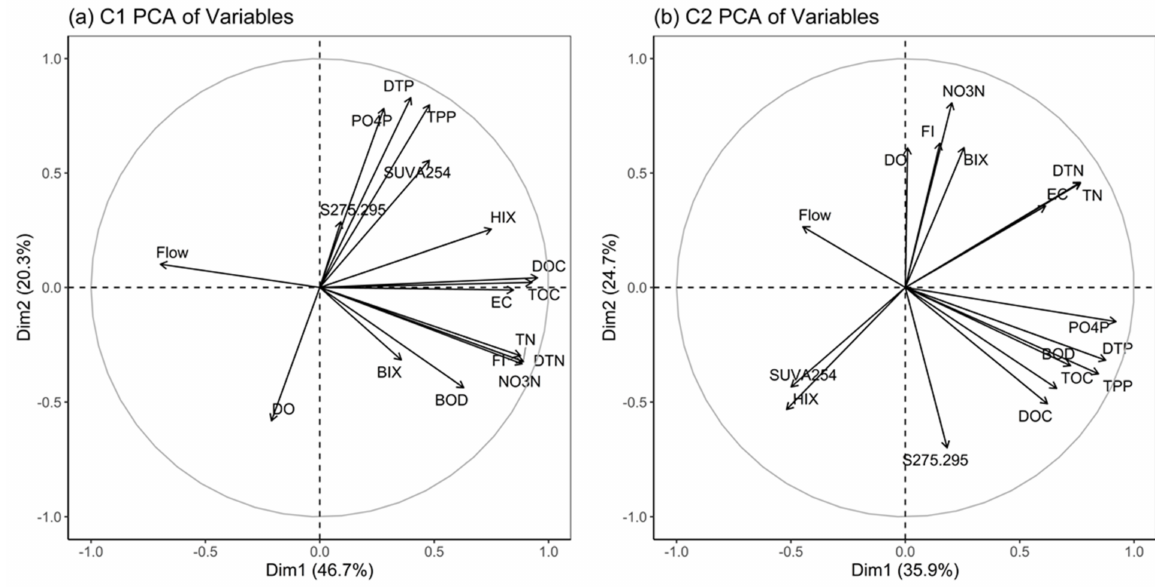
Figure 9. PCA variables of Cluster 1 ( a ) and Cluster 2 sites ( b